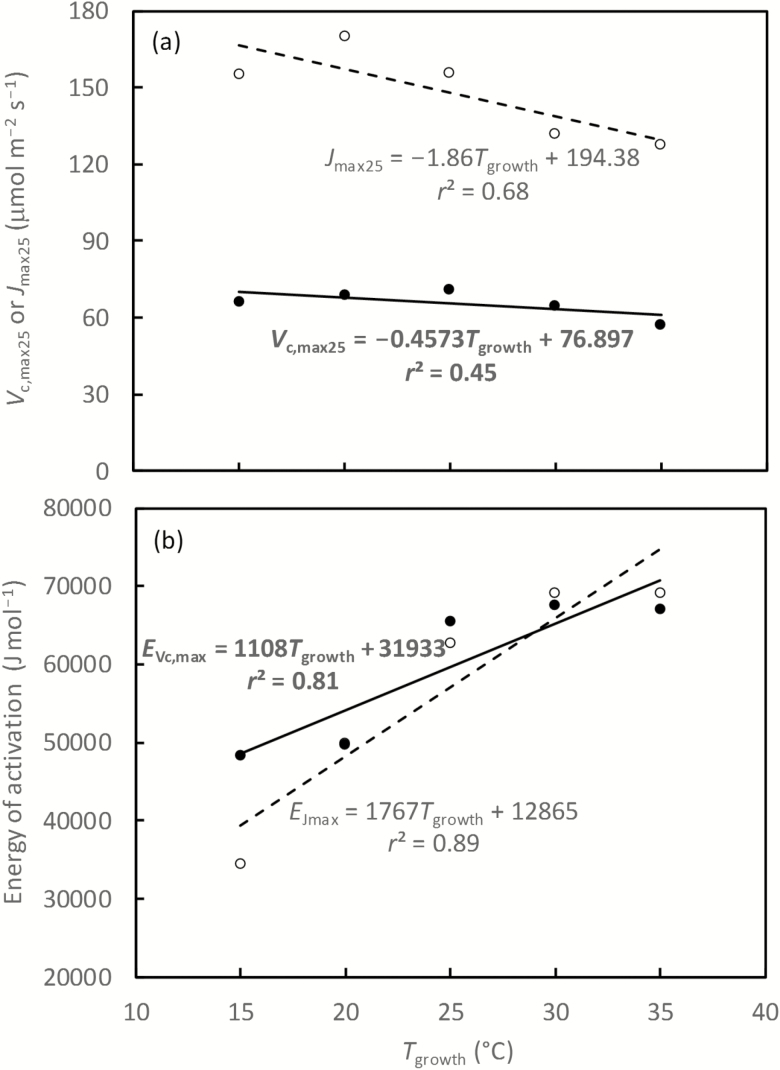
Estimated values of the FvCB model parameters plotted against growth temperature Tgrowth: (a) Vc,max25 (filled symbols and the solid line) and Jmax25 (open symbols and the dashed line), (b) EVc,max (filled symbols and the solid line), and EJmax (open symbols and the dashed line). See the text for details of the data that were generated for the analysis shown in this figure.